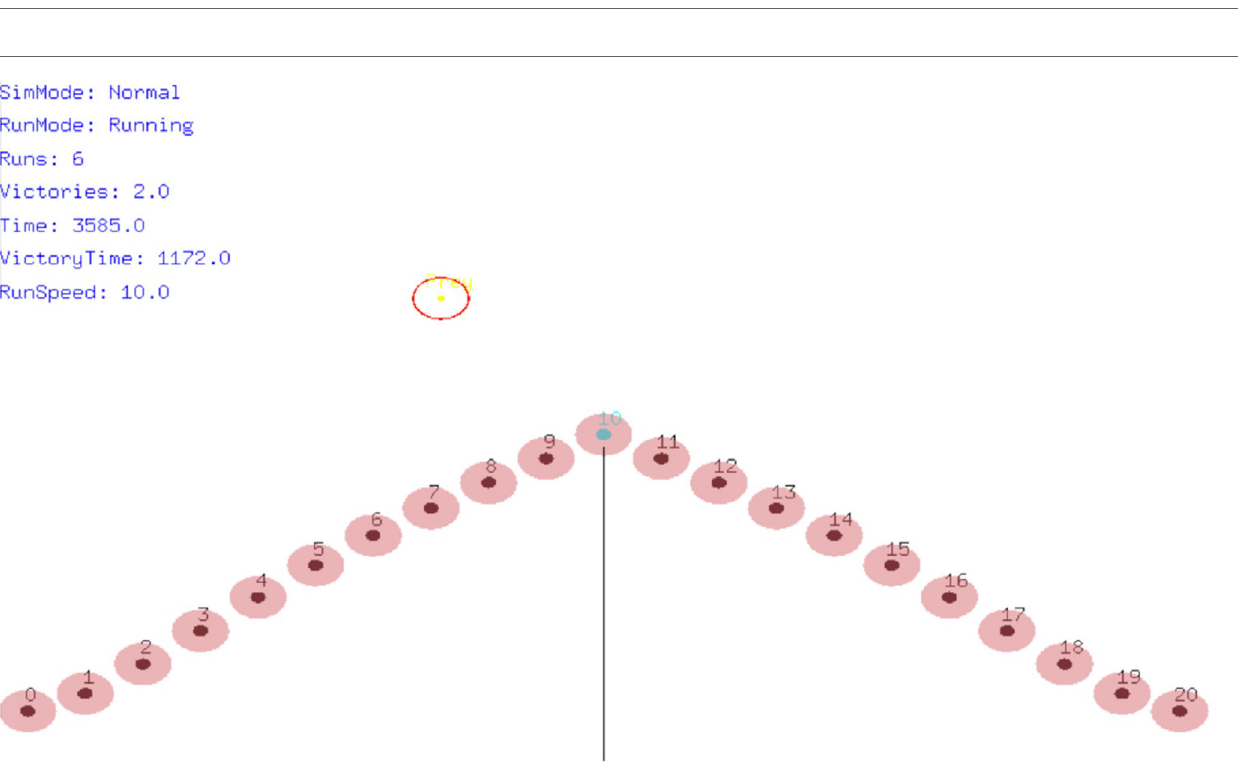
FigUre 8 | (a) Placing path pheromones (in yellow) from the start may ensure that several individuals (in green) define new trails in a common direction. Competition among these trails will determine the most efficient path through an area populated with static and mobile obstacles, brown/white and purple boxes, respectively. (B) Omnidirectional sensitivity for pheromones results in high density trails at the base station. (c) Furthermore, scattered sensitivity ensures a wider coverage of the target area.